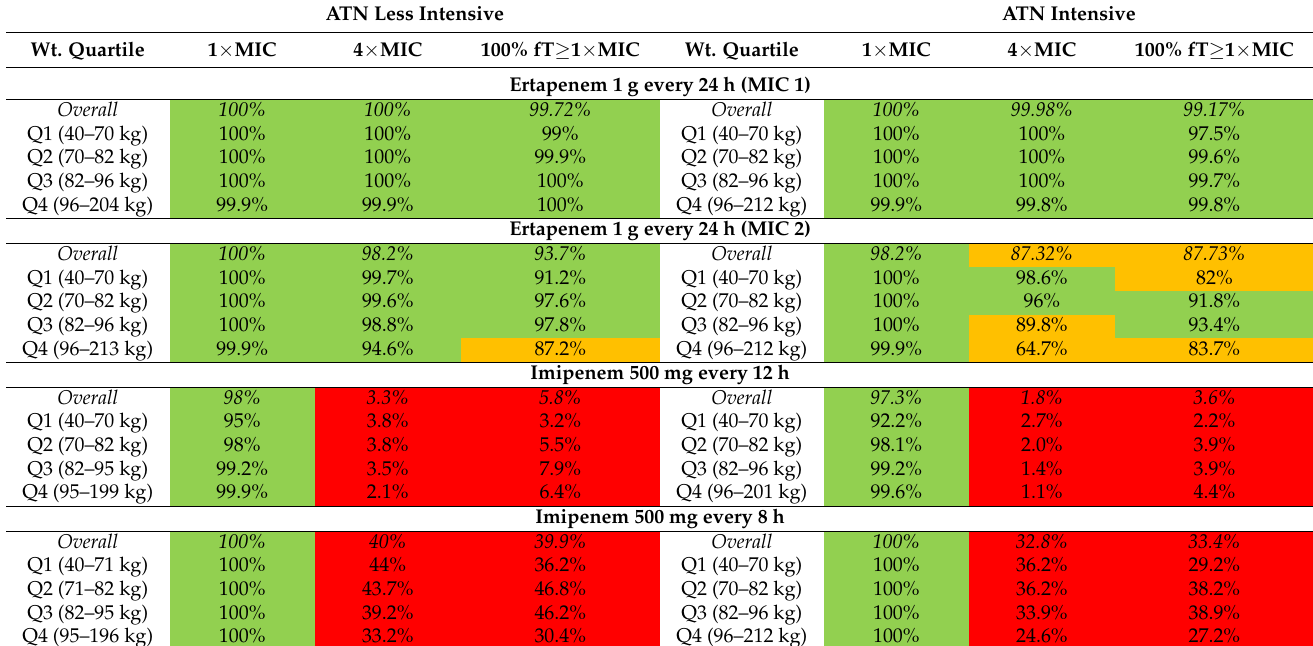
Table 2. Probability of target attainment comparison among weight quartiles for key carbapenems used in the ATN trial: ertapenem, imipenem, and